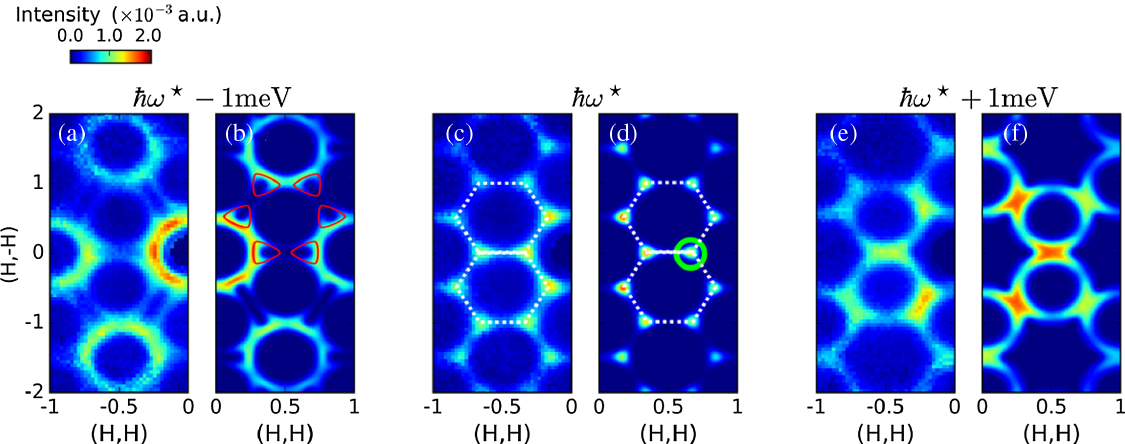
FIG. 5. (a,c,e) Constant energy slices of the CoTiO 3 magnon spectra in the ( H; K ) plane. The constant energy of each slice is chosen to be at the Dirac point crossing with ℏ ω ⋆ ∼ 8 . 5 meV (c), 1 meV below ℏ ω ⋆ (a), and 1 meV above ℏ ω ⋆ (e). Since magnon spectra in CoTiO 3 have almost no L dependence at energies close to ℏ ω ⋆ , all spectra have been integrated over all L measured to improve statistics. (b,d,f) Calculated intensity maps using the same parameters as in Fig. 3. The calculated spectra are convolved with an energy resolution of 1 meV. An energy integration range of 0.5 meV has been used for both the experimental data and calculation. White dashed lines in panels (c) and (d) denote the boundaries of 2D BZs. Red triangles in panel (b) are loops in a constant energy slice of the magnon dispersion below the Dirac points. As in Fig. 3(l), the green circle in panel (d) indicates the position of the Dirac point K 00